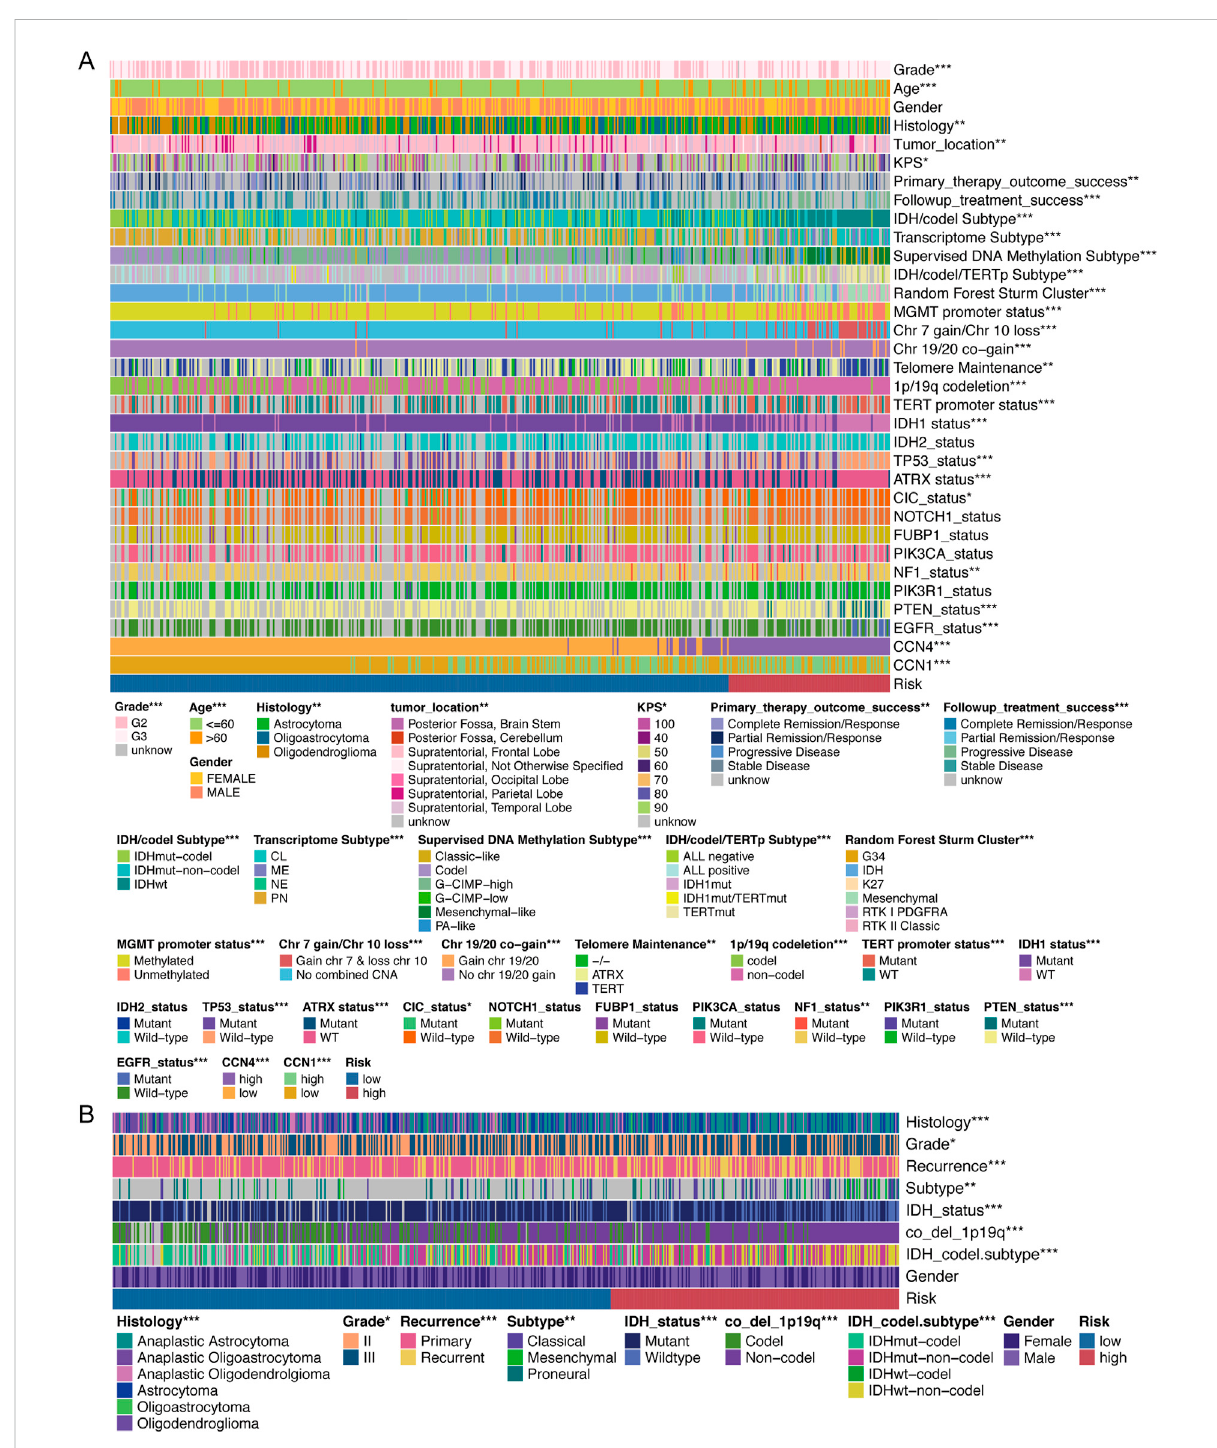
FIGURE 4 Relationship between CCNScore and clinical traits. (A) Correlation heatmap of CCNScore versus clinical traits in the TCGA-LGG cohort. (B) Correlation heatmap of CCNScore versus clinical traits in the CGGA-LGG cohort. * p < 0.05, ** p < 0.01, *** p <